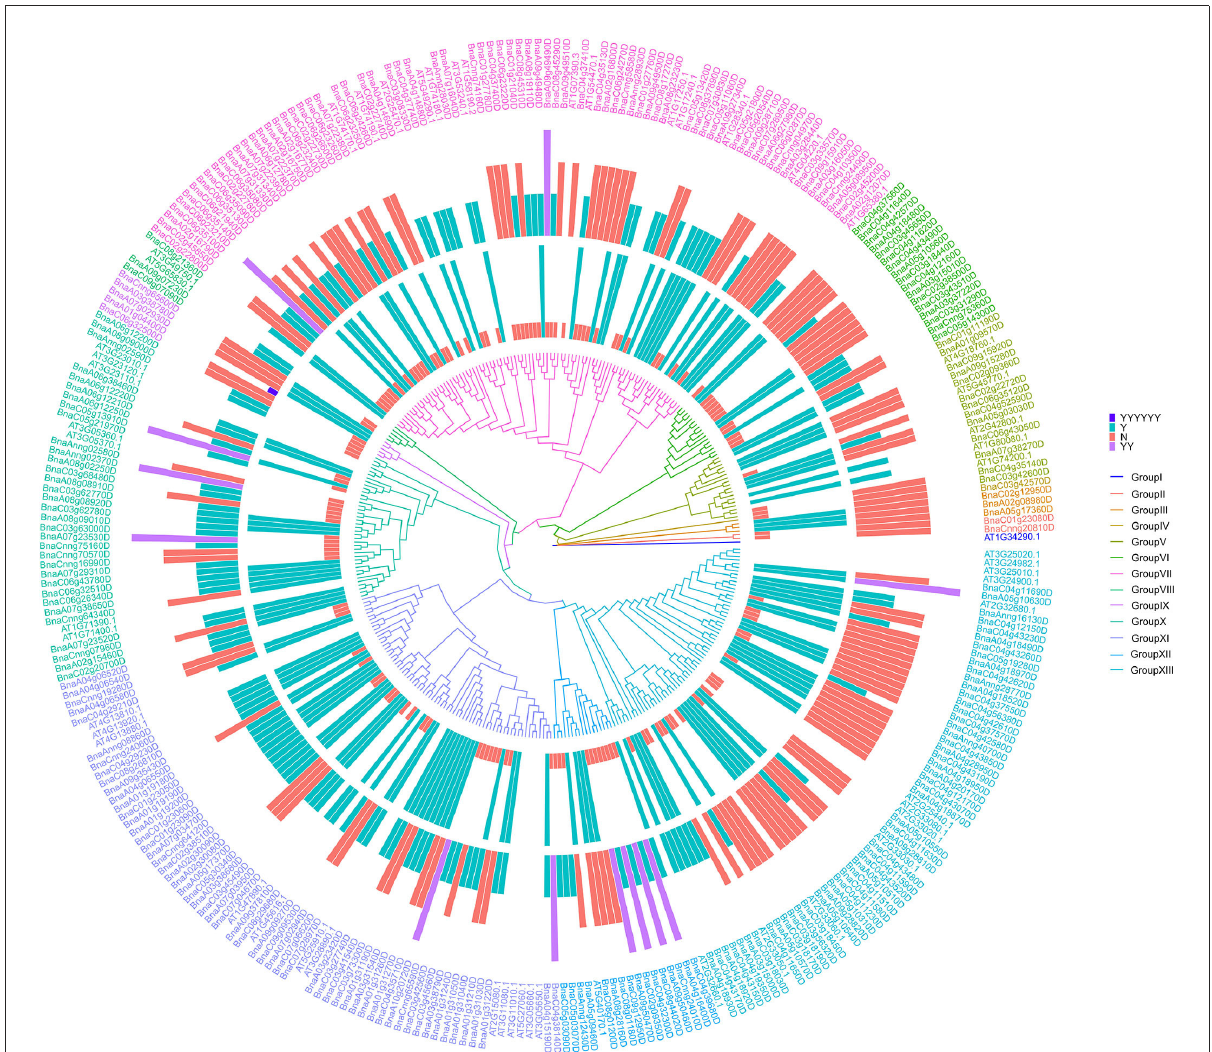
FIGURE4 Phylogenetic trees of RLP proteins in Arabidopsis thaliana and Brassica napus . The phylogenetic tree was generated by the ML method with bootstrap analysis (1,000 bootstrap replicates) using an amino acid sequence alignment of RLP proteins from A. thaliana and B. napus by the MEGA 7.0 program. RLP proteins were clustered into 13 subgroups. The rings surrounded by the phylogenetic tree stand for two types of domains. The inner one represents the transmembrane domain and the outer represents the signal peptide. “Y” means that RLP contains one transmembrane domain/signal peptide, “YY” for two transmembrane domains, and “YYYYYY” for six transmembrane domains. “N” means that RLP does not contain transmembrane domain/signal